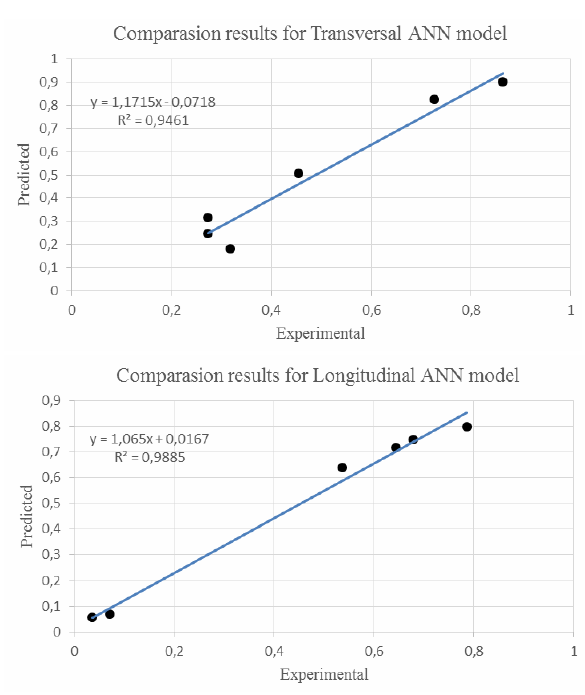
Figure 3 : Regression Analysis Results of two Developed ANN Models.